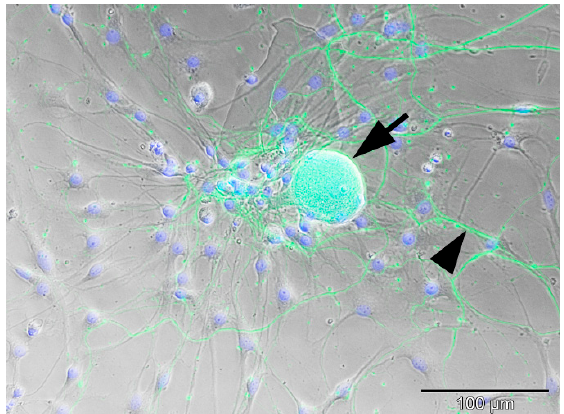
Figure 1. Overlay of phase-contrast and immunofluorescence-images of a non-infected, non-cryopreserved canine DRG neuron at 6 DiV: green = pan-NF; blue = bisBenzimide nuclear stain. The neuron has a large, granular cell body with a phase-bright halo (arrow), is adherent to the substrate, and shows outgrowth of branched neurites (arrowhead). It is surrounded by spindeloid, bi- to multipolar glial cells with delicate processes (blue nuclei) lacking neurofilament staining. Pan-NF = pan-neurofilament, DiV = days in vitro, DRG = dorsal root